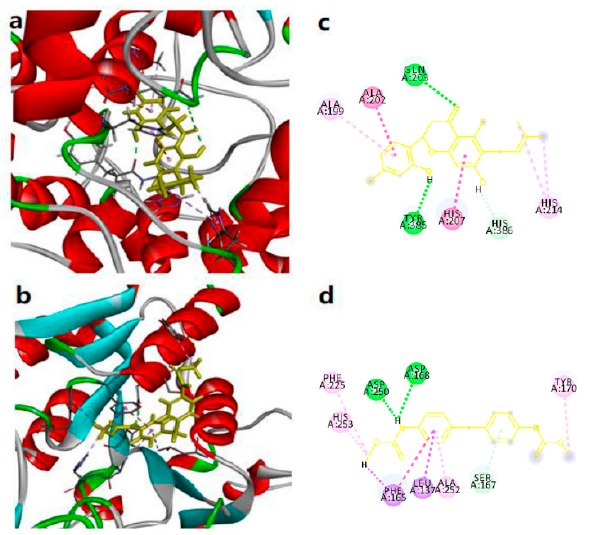
Figure 6. ( a ) Molecular model of most active molecule in the compound 19 in the protein PTGS2 (protein data bank ID chimeric 5F19). Active site amino acid residues are represented as tubes, while the inhibitor is shown as stick model with yellow colored. ( b ) Molecular model of most active molecule in the compound 4 in the protein KYNU (protein data bank ID chimeric 2HZP). ( c ) Schematic (2D) representation of interactions of compound 19 in the binding pocket of the protein. ( d ) Schematic (2D) representation of interactions of compound 4 in the binding pocket of the